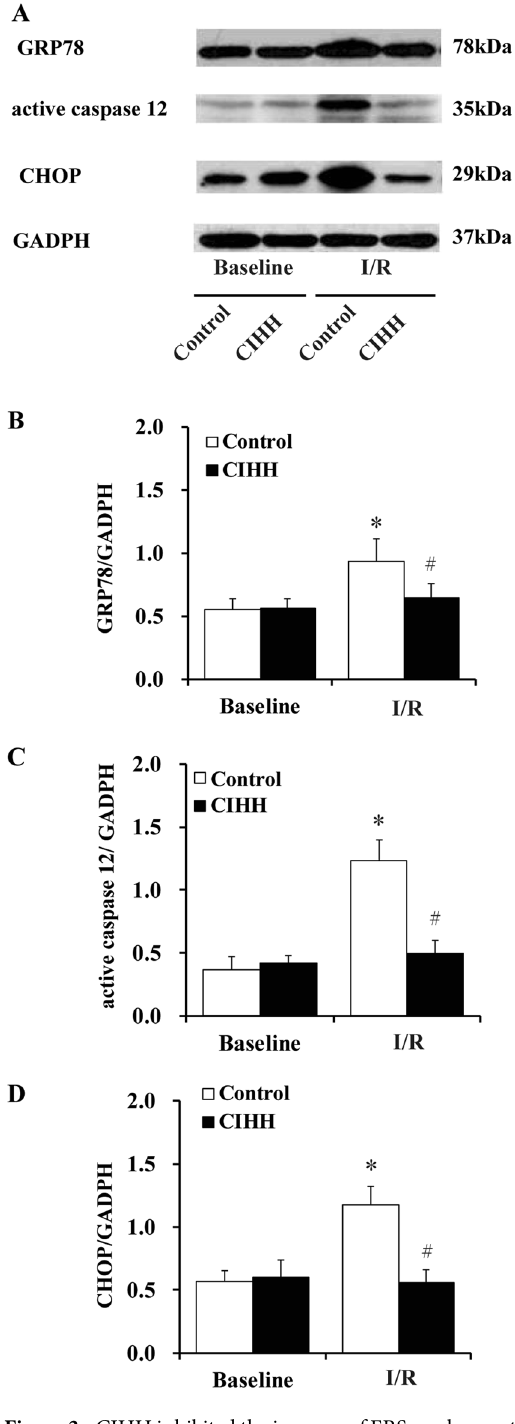
Figure 3. CIHH inhibited the increase of ERS marker proteins induced by I/R. ( A ) Representative protein expression of GRP78, active caspase-12, CCAAT/enhancer binding protein homologous protein (CHOP); ( B – D ) Quantitative analysis of protein expression of GRP78, active caspase 12, and CHOP. All data were expressed as mean ± SD, n = 6 for each group. * P < 0.05 vs each corresponding baseline group. # P < 0.05 vs CIHH I/R